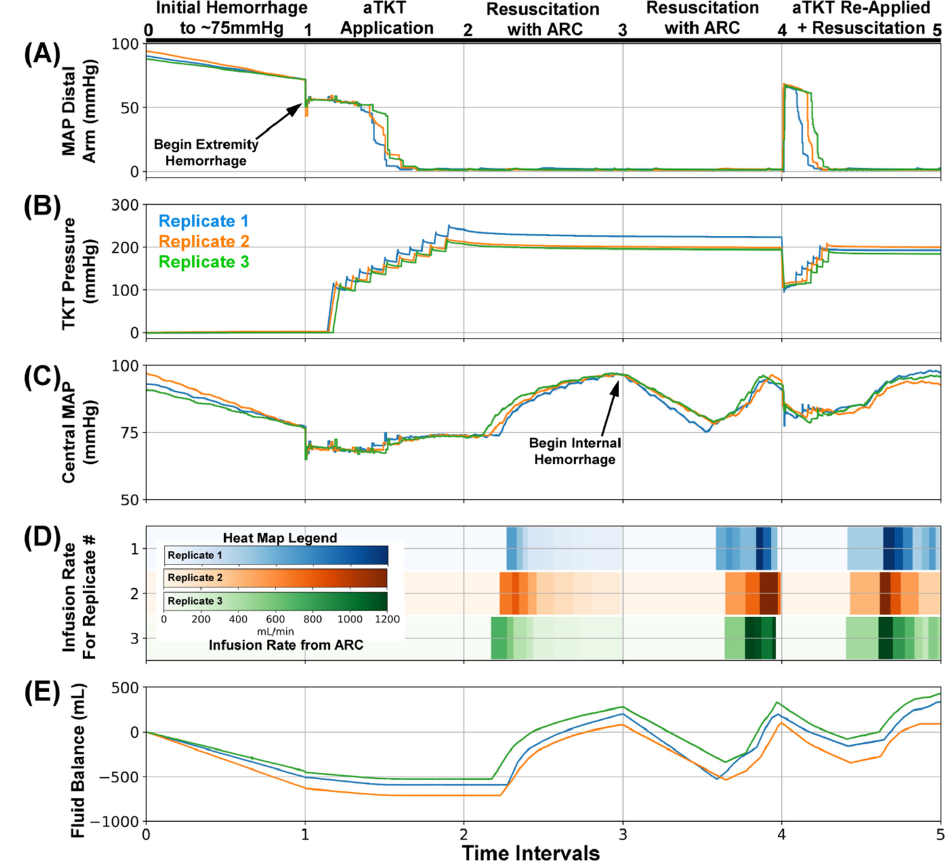
Figure 9. SACM Testing Scenario #5. After (0–1), the initial hemorrhage reduced blood pressure to approximately 75 mmHg, (1–2) extremity hemorrhage was stopped by aTKT, (2–3) and resuscitation restored pressure to 95 mmHg by ARC. Next, (3–4) an internal hemorrhage (240 mL/min) was in- duced, causing central MAP to fall to 85 mmHg in which SACM detected the reduction and resus- citated after checking the tourniquet cuff pressure did not slip. Lastly, (4–5) while internal hemor- rhage (240 mL/min) continued, tourniquet cuff pressure was slightly reduced to mimic loosening, which was detected by SACM and re-inflated by aTKT algorithm, followed by resuscitation up to 95 mmHg. Aligned results are shown for ( A ) MAP distal to the bleed site (mmHg, PT2), ( B ) Tourni- quet Cuff pressure (mmHg), ( C ) Central MAP (mmHg, PT1), ( D ) Resuscitation flow rate (mL/min), and ( E ) overall system fluid balance (Infused Volume—Hemorrhage Volume, mL). Three individual replicates are shown to illustrate the similarities and difference between each replicate run. 4. Discussion Medical automation holds the potential of simplifying the delivery of both civilian and military emergency medical care by making rapid patient management decisions, thus cognitively offloading caregivers in situations where they can be overwhelmed. Ven- tilator, resuscitation, and anesthesia medical systems are just a few systems with recent advancements toward closed-loop, fully autonomous operation. However, as multiple au- tomated systems emerge, control systems and algorithms will be needed to coordinate operation across these systems or applications to ensure physiological data are being tracked and managed appropriately as the patient status changes. Here, we highlighted